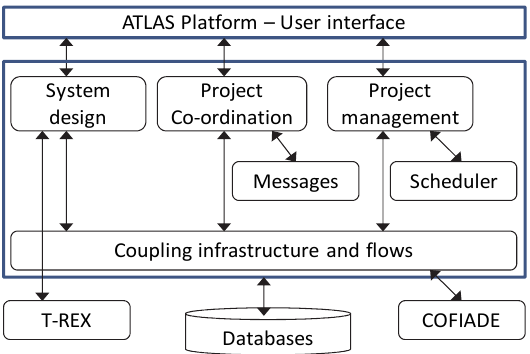
Fig. 3. Architecture of ATLAS